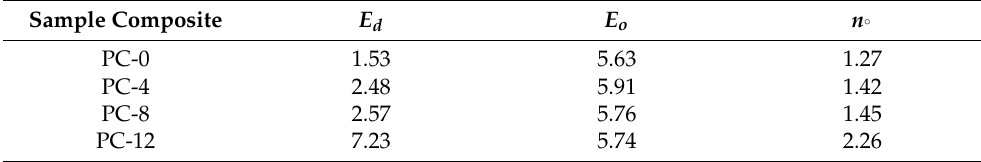
Table 7. Optical band gap calculated from the single oscillator model, established by Wemple–DiDomenico. Sample